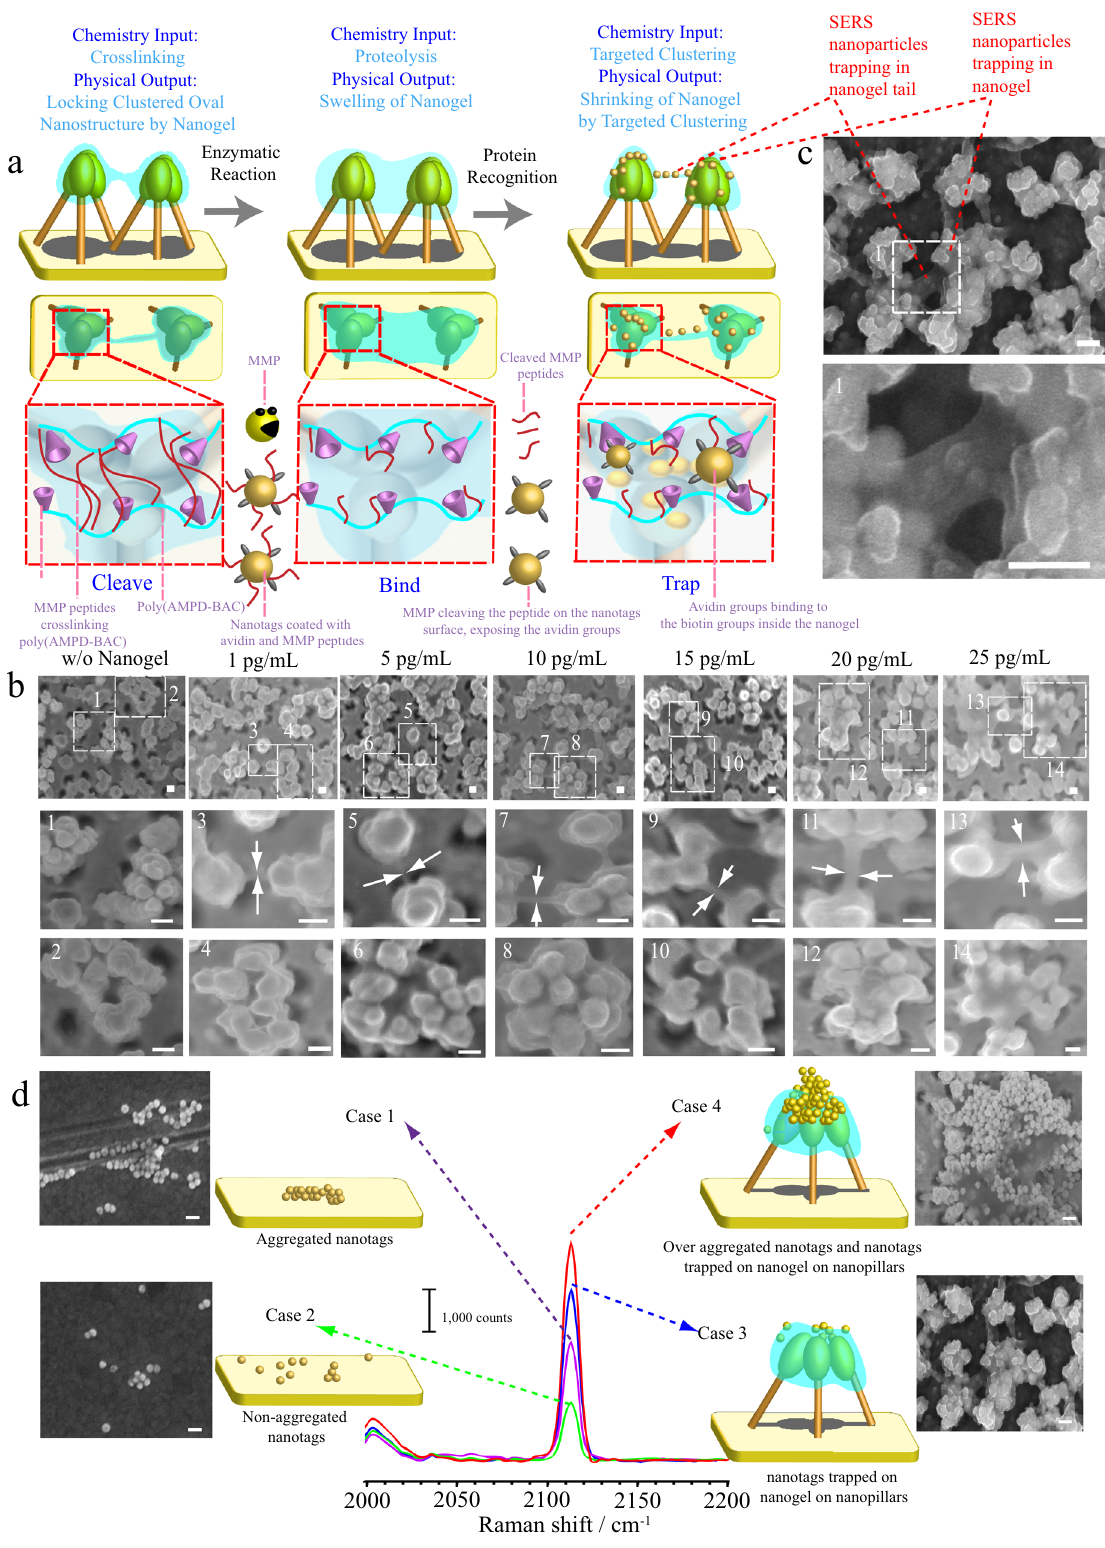
Fig. 4 Study of cleave-bind-and-trap detection mechanism. a Schematic illustration of the cleavage-binding-and-trap detection mechanism involving MMP peptide cleavage, biotin-avidin recognition and SERS nanoparticles trapped in nanogel. b A series of SEM experiments demonstrating nanogel swelling associated with the concentration of MMP-2. c Trapping process of nanotags in nanogel as evidenced by SEM images. d CO intensity enhanced by nanotags, aggregated nanotags and clustered nanotags on nanopillars. A representative image of three individual experiments is shown (scale bar: 100